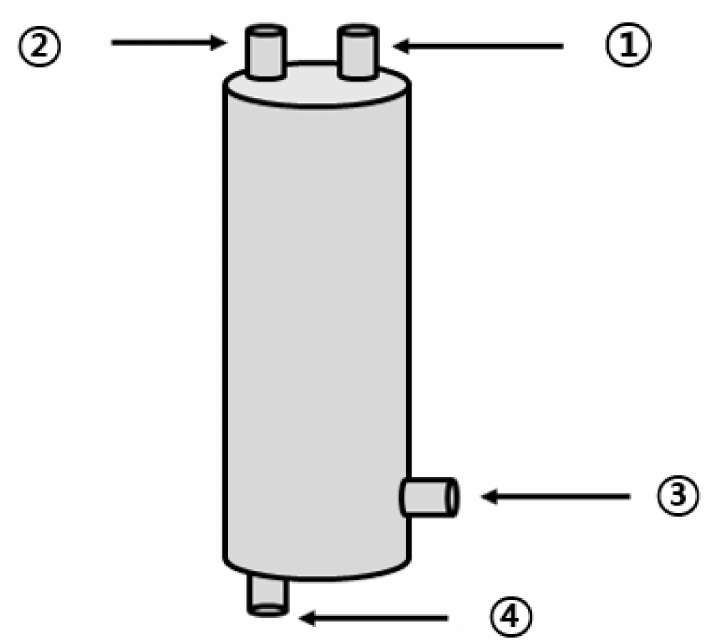
Figure 1. Schematic diagram of the thermal hydrolysis reactor (1: pressure gauge; 2: steam outlet; 3: steam inlet; 4: thermal hydrolysis byproduct outlet).